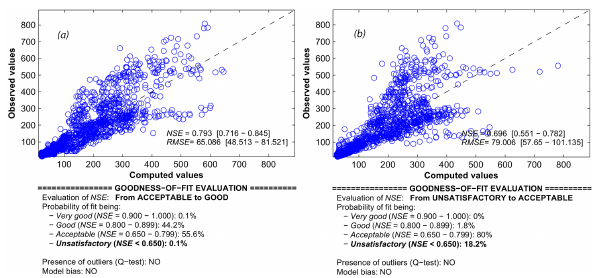
Figure 5. Goodness-of-fit evaluation for validation period (1973– 1990) at the Illecillewaet watershed: (a) UBCANN method and (b) UBCCLA method.